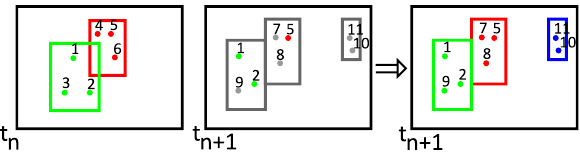
Figure 2. Propagation of object IDs from one frame to the next. Point IDs are shown by a number and object IDs by colour, grey indicates that no object ID is